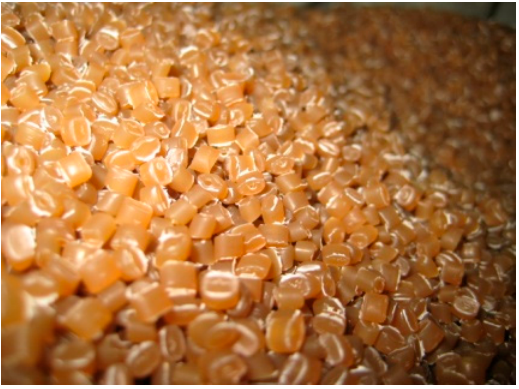
Figure 3. The exterior of the superconcentrate granules.